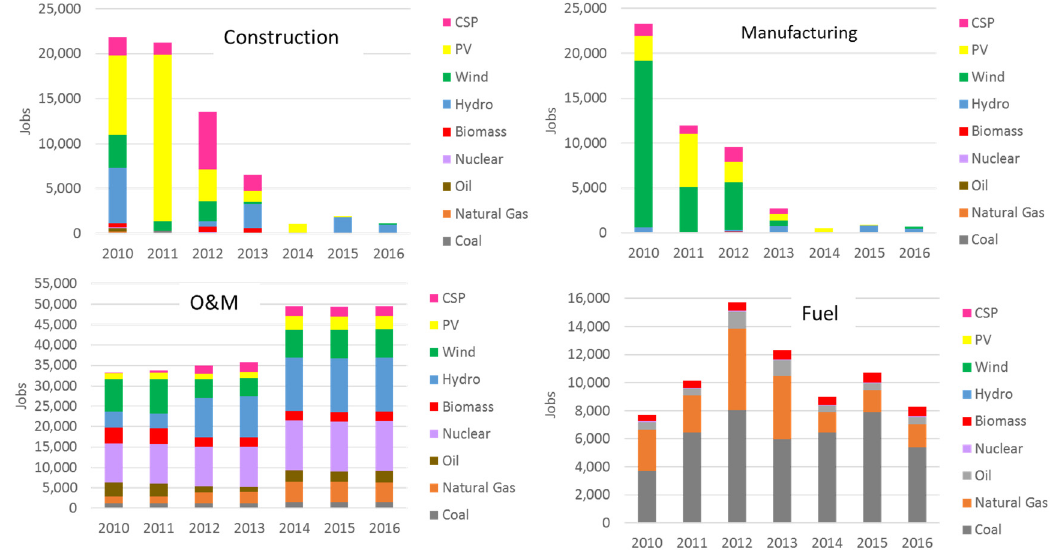
Figure 14. Employment generation in the Spanish electricity system since 2010 and disaggregated per life cycle phases: construction and installation of power plants (top left), raw materials and manufacturing of components (top right), operation and management of power plants (bottom left) and fuel production (bottom right).